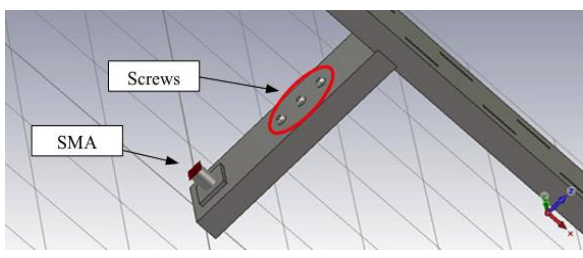
Figure 5. Screen shot of the antenna model showing the three screws.